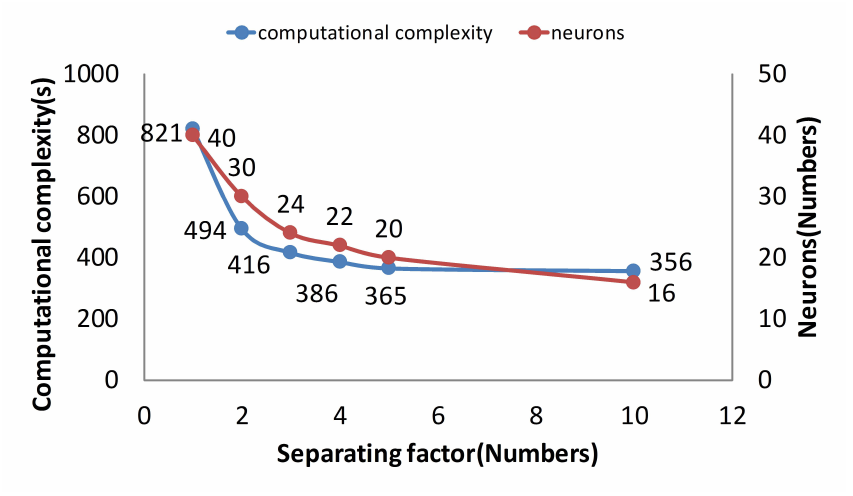
Figure 12. The computational complexity of different separating